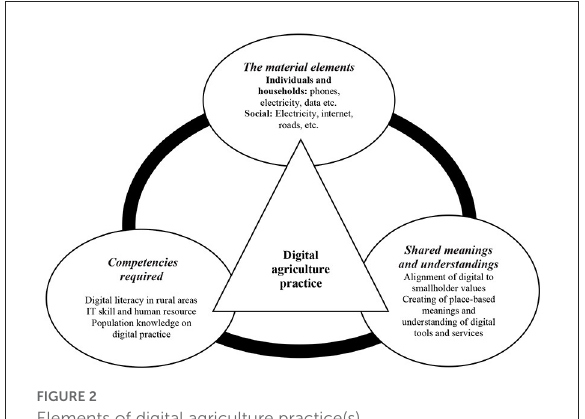
FIGURE2 Elements of digital agriculture